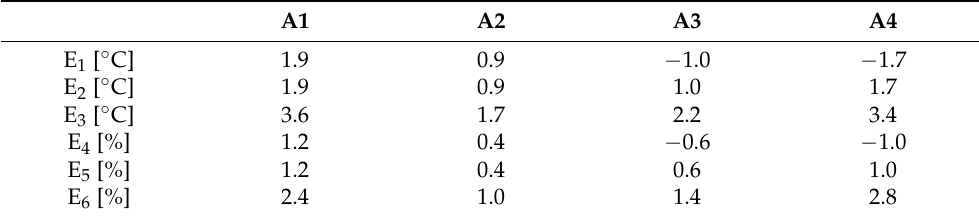
Table 4. Values of estimates E 1 –E 6 for temperatures (14)–(19) with heating process p1 in planes